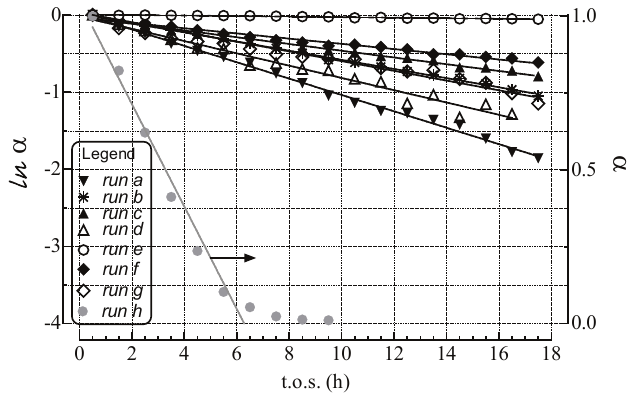
Figure 5. Plot of the relative activity at different experimental conditions (see Table 1) vs.